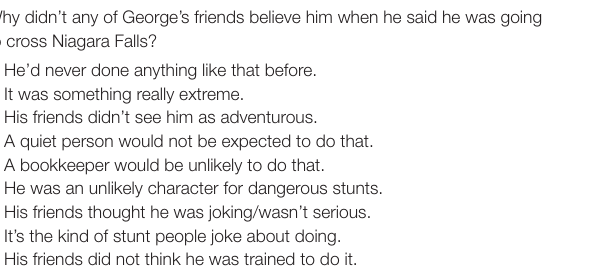
TABLE 3 | Example inference question with potential